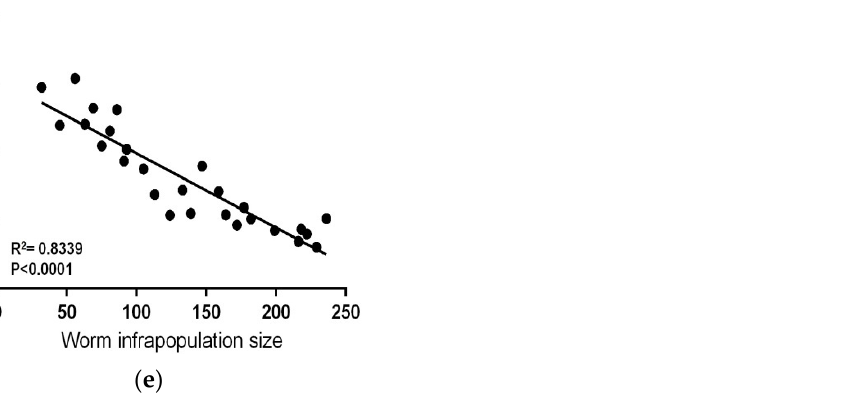
Figure 4. The relationships between levels of selected biochemical parameters in fish blood serum and worm infrapopulation size in fish intestine: ( a ) glucose level in fish serum vs. worm infrapopulation size, ( b ) triglycerides level in fish serum vs. worm infrapopulation size, ( c ) total protein level in fish serum vs. worm infrapopulation size, ( d ) albumin level in fish serum vs. worm infrapopulation size, ( e ) urea level in fish serum vs. worm infrapopulation size.